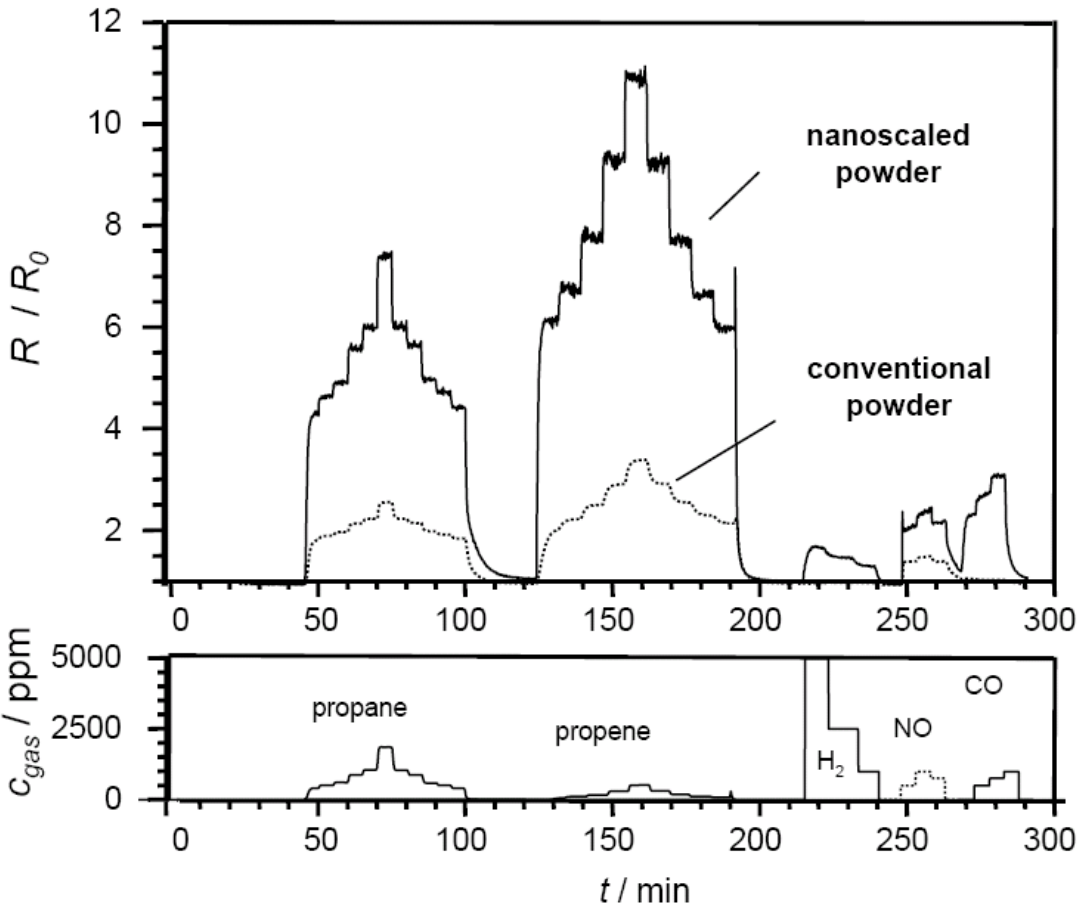
Figure 1. Impact of the particle size on sensor response R/R prepared from microscaled mixed-oxide powders (dotted line) and nanoscaled sol- precipitated precursors (solid line). Test gases as indicated in the bottom part, operating temperature: 400 °C, balance: dry